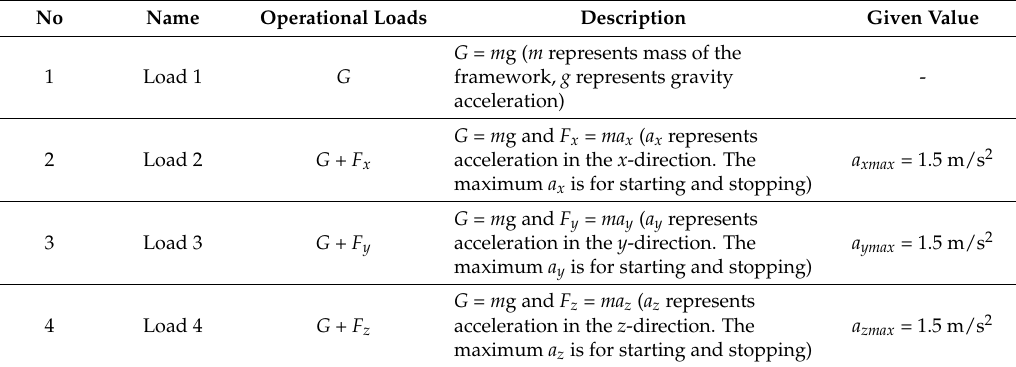
Table 5. Operational loads for the milling head in the manufacturing process.